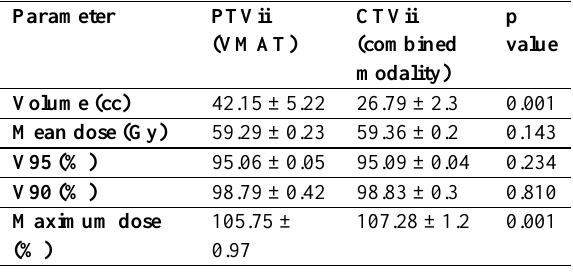
Table 1: Comparison of means of target volumes coverage in both sum plans